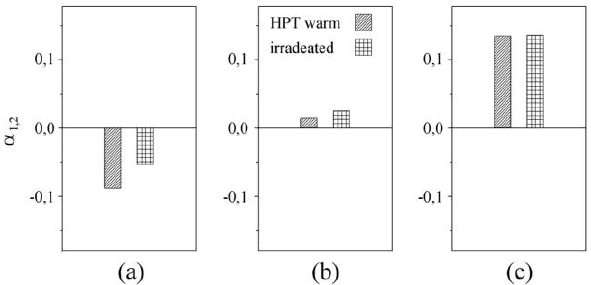
Figure 8. Cowley parameter  1,2 for ( a ) Fe 94 Cr 6 ; ( b ) Fe 90.6 Cr 9.4 ; ( c ) Fe 86.8.2 Cr 13.2 alloys. Each treatment is indicated in the